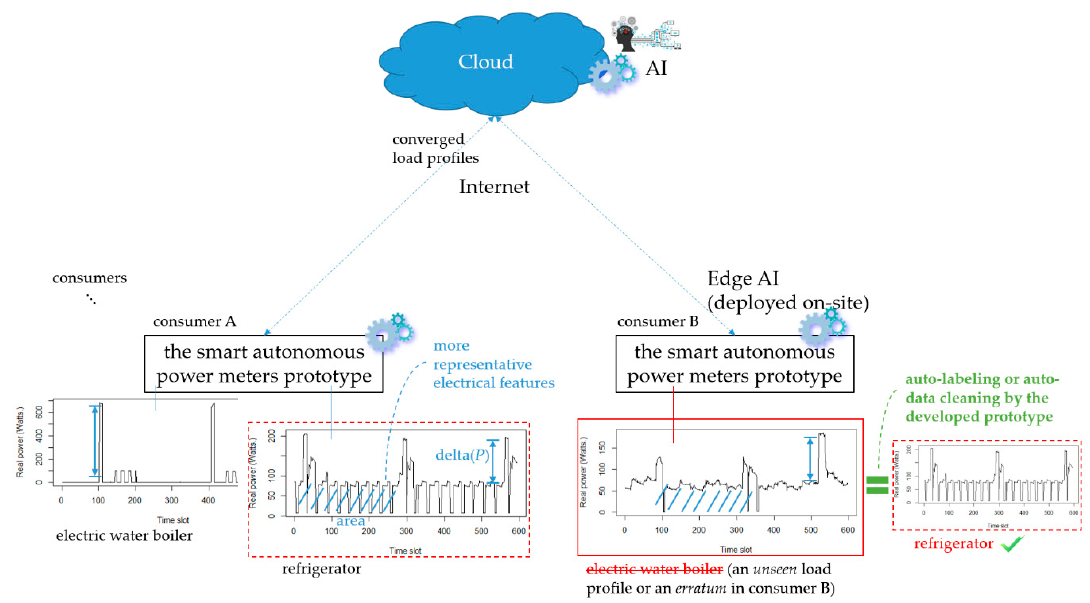
Figure 12. Demonstration of auto-labeling or auto-data cleaning by means of online load identification performed onsite on the developed prototype through converged analytics (as edge-to-edge connectivity).